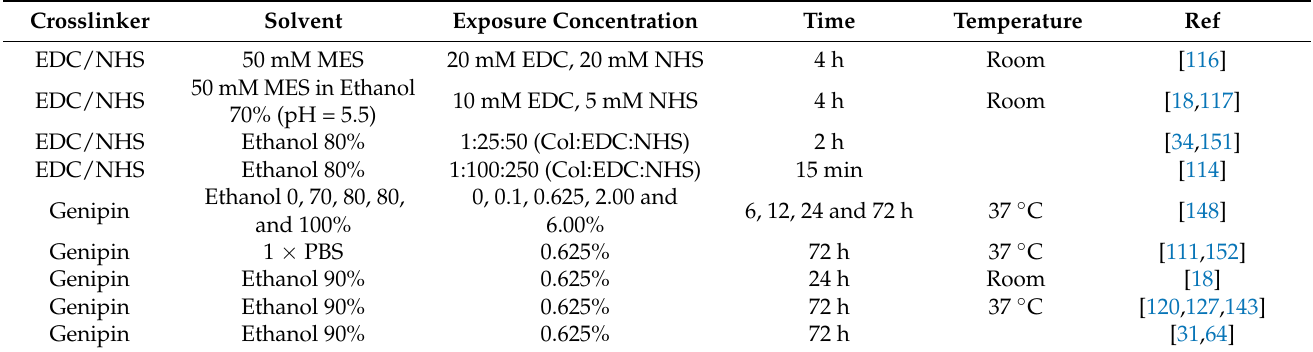
Table 4. Summary of crosslinking protocols used for collagen